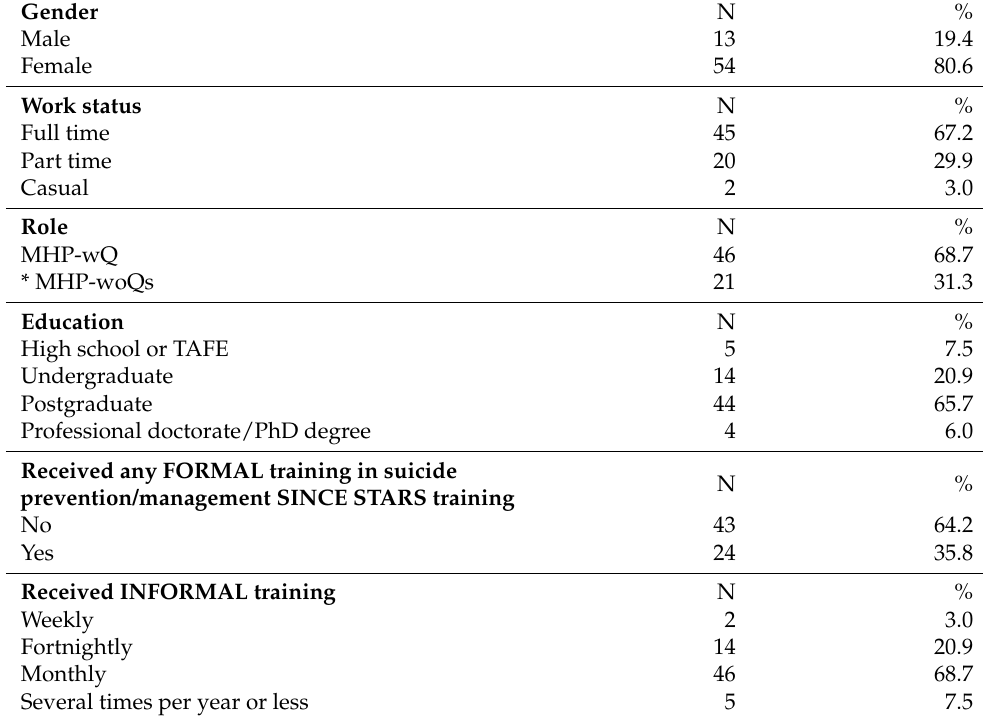
Table 1. Description of participants (N =